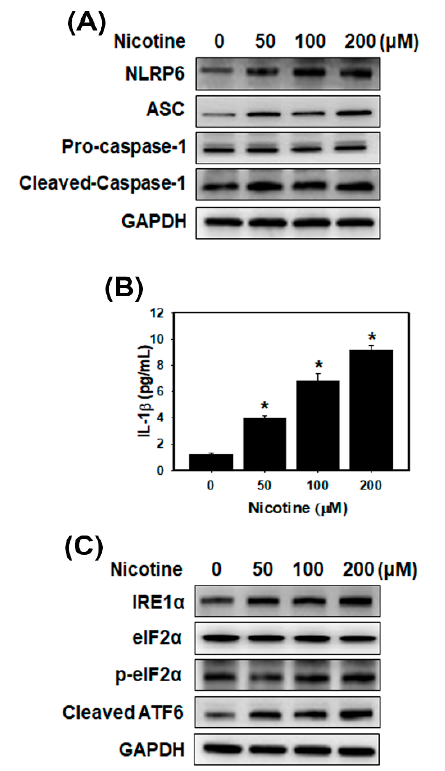
Figure 2. Effects of nicotine treatment on the NLRP6 inflammasome and endoplasmic reticulum (ER) stress in human kidney cells. ( A ) Western blotting for NLRP6 inflammasome-related proteins in HK-2 cells. ( B ) The levels of IL-1 β in the culture medium were determined using an ELISA. Data are presented as the means ± standard deviation of three independent experiments. * p < 0.05 compared with the control. Statistical significance was estimated with ANOVA by Dunnett’s multiple comparison test. ( C ) Western blotting for ER stress-related proteins in HK-2 cells. The cells were treated with the various concentrations of nicotine for 24 h.